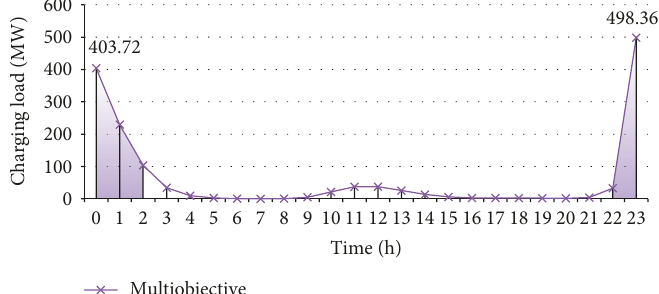
Figure 9: The hourly charging load via the multiobjective strategy.